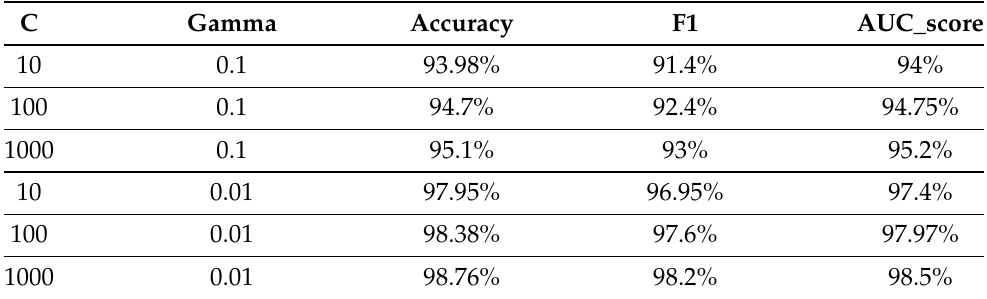
Table 3. The experimental results for SVM parameters showing the best hyper-parameters for SVM